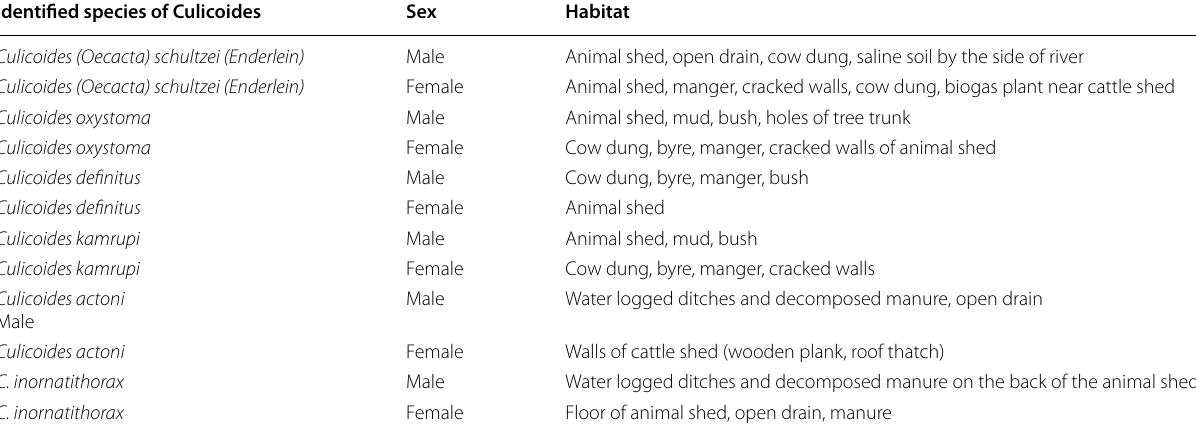
Table 12 Habitat of collected